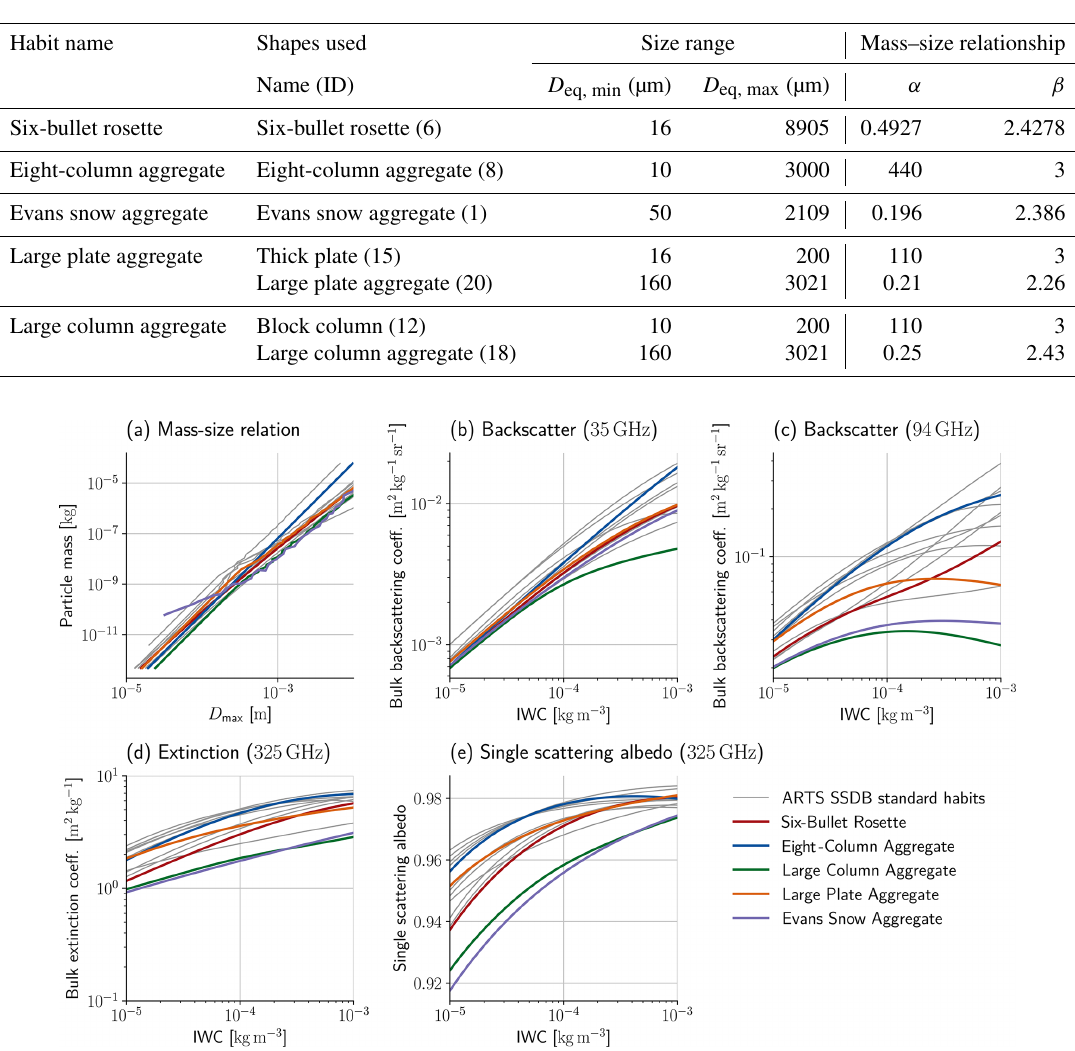
Table 3. Particle habits used in the retrieval. The mass–size relationship is given in terms of the parameters of a fitted power law of the form m = α · D β with D MAX the maximum diameter and m in kg. MAX